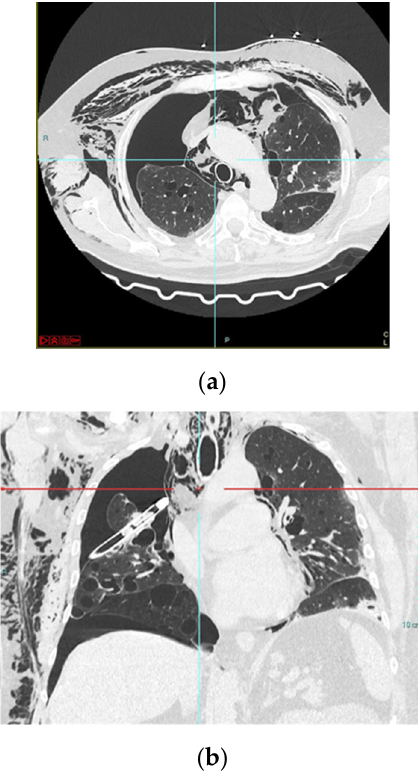
Figure 2. A typical case of a COVID-19 pneumothorax and pneumomediastinum patient ( a ) chest TC showing pneumothorax extended at 75% of the right lung and large mediastinal emphysema; ( b ) Coronal CT showing chest drainage for pneumothorax at right lung anteroposterior projection image.